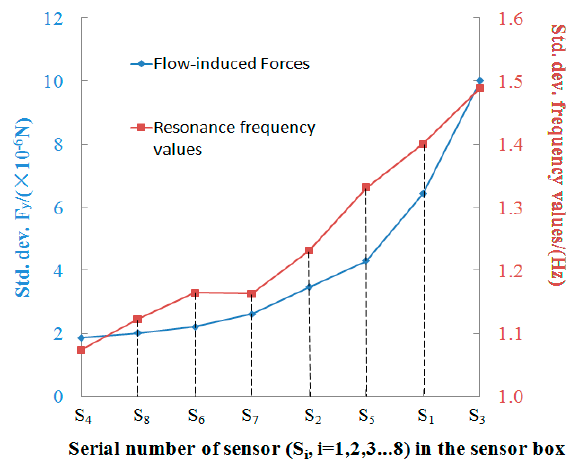
Figure 16. Blue line chart: Standard deviation of flow-induced force (F y ) of each sensor. Red line chart: Standard deviation of frequency values of each sensor.